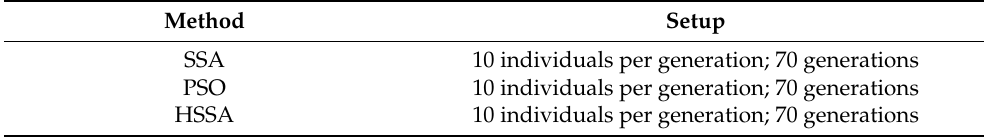
Table 8. Settings of each algorithm in the meaning verification experiment. Method Setup